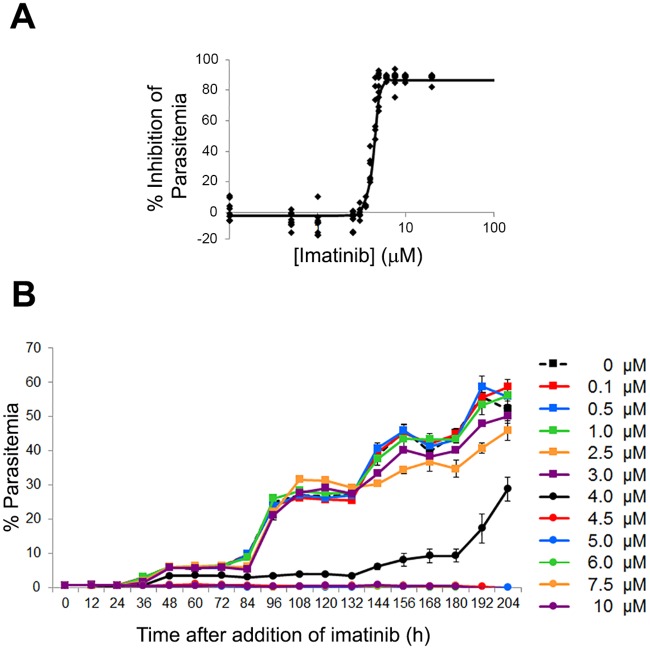
Effect of imatinib on survival of P. falciparum malaria in human erythrocyte cultures.(A) Effect of different concentrations of imatinib on the survival of P. falciparum in human erythrocyte cultures. Synchronized ring stage (12hpi) P. falciparum (Palo Alto strain) cultures at 0.5% parasitemia were treated with the indicated concentrations of imatinib, and after 60h incubation, % parasitemia was quantitated by flow cytometry (see Methods). Results were obtained from three independent experiments, with each concentration examined in triplicate in each experiment. (B) Effect of a single treatment of imatinib on the long term survival of P. falciparum in human erythrocyte cultures. Synchronized ring stage parasites were treated 12h post-infection (time 0) with increasing concentrations of imatinib and % parasitemia was evaluated every 12 hours, as described above. To assure the continuous availability of nutrients for any proliferating parasites and to prevent loss of parasitized RBCs during media replacement, 2/3 of the media was replaced with fresh media every 24h beginning at the 72-hour time point. Results were obtained with each concentration examined in triplicate.